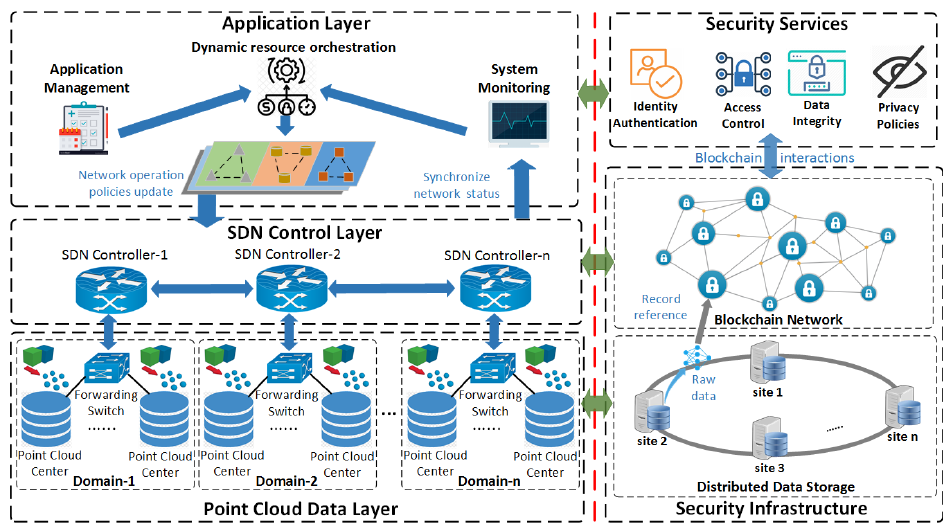
Figure 1. System architecture of